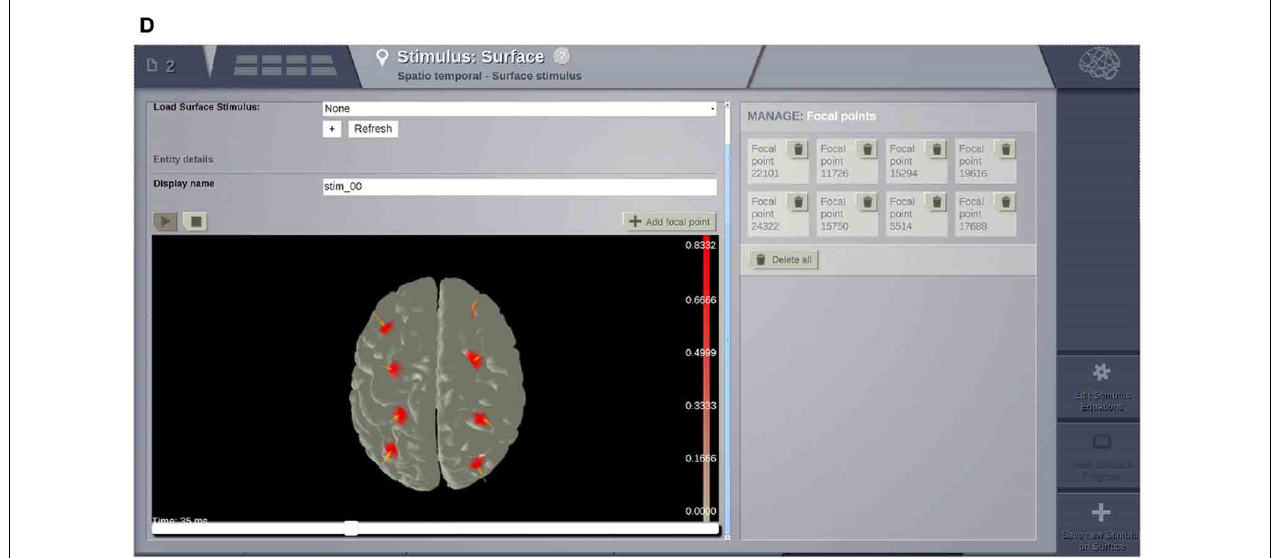
FIGURE 6 | Visualizers. (A) Histogram of a graph metric as a function of nodes in the connectivity matrix. (B) A 2D projection of the head. The color map represents a graph metric computed on the connectivity matrix. (C) EEG visualizer combines a rendered head surface, an overlay